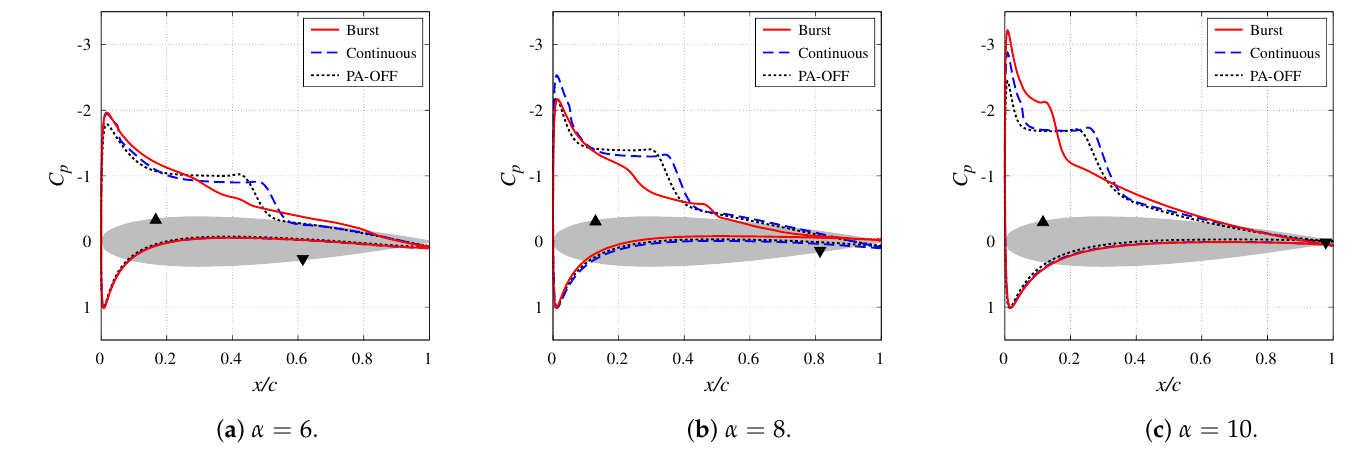
Figure 9. Pressure coefficient ( C p ) distributions around the